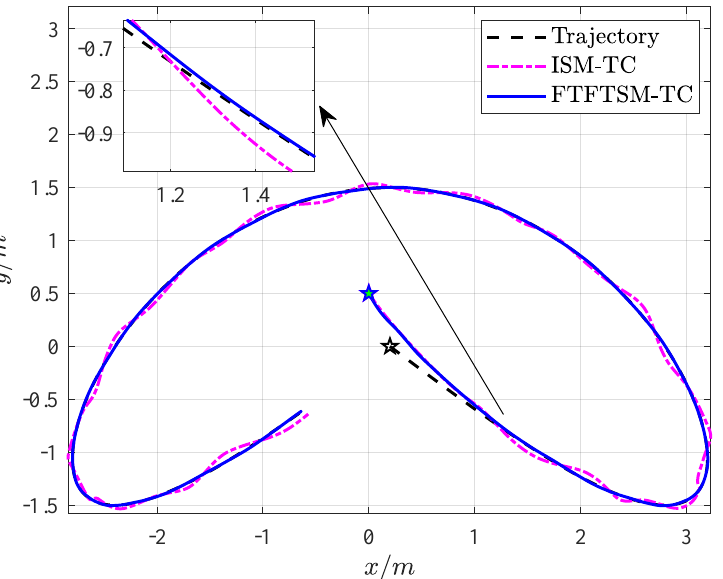
Figure 3. Tracking curve of FTFTSM-TC and ISM-TC. The asterisk represents the start position of the USV.